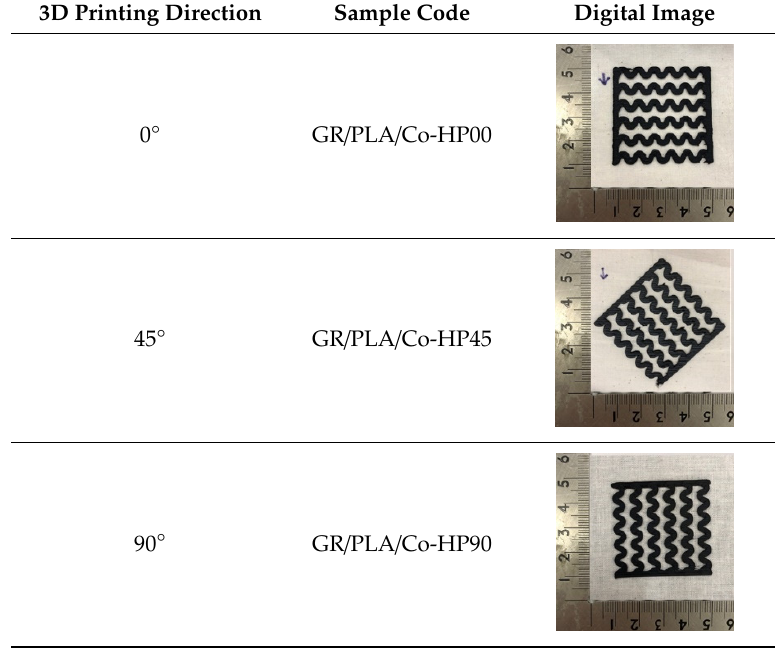
Table 3. Sample codes and digital images of CFDM 3D-printed horseshoe pattern/cotton composite fabric with different 3D printing directions.